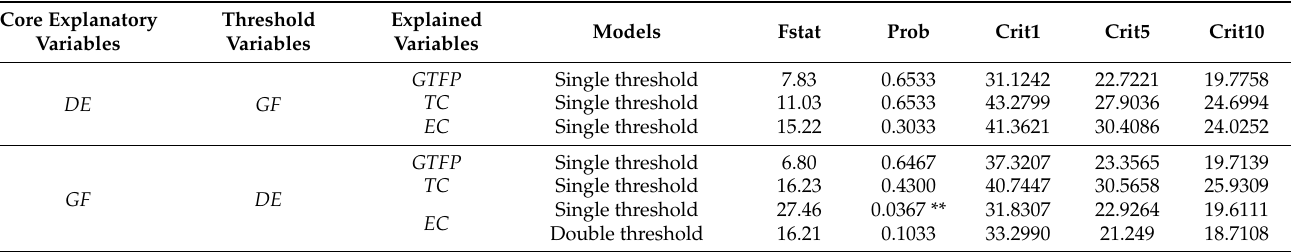
Table 7. Threshold effect